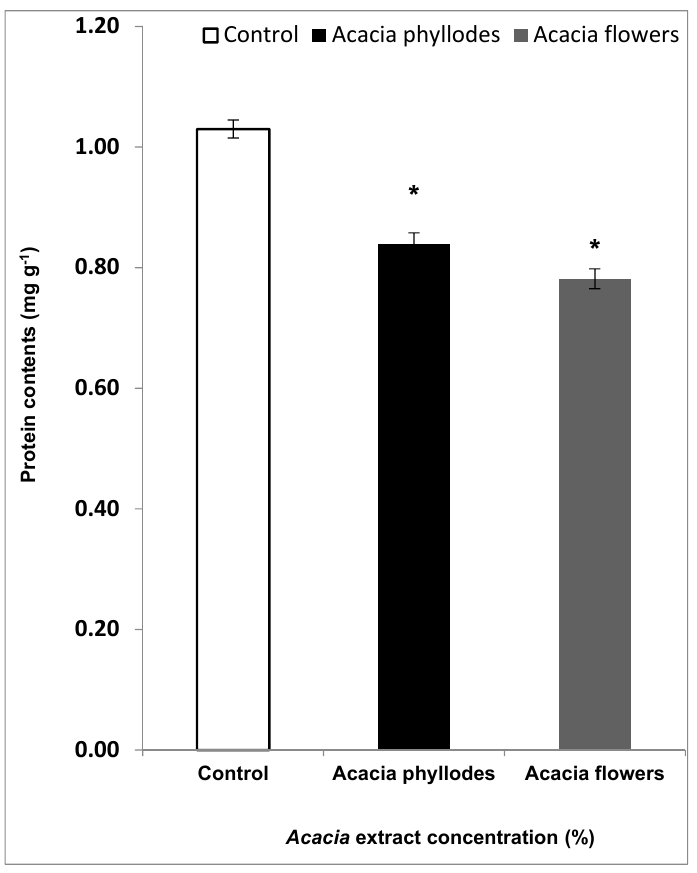
Figure 1. Inhibitory effects of A. melanoxylon flowers and phyllodes extract (0% and 100%) on the leaf protein contents (mg / g) of Lactuca sativa . Each bar represents the mean ( ± S.E.) of three replicates. *Asterisks indicate significant differences at level 0.05 with respect to the control. Table 5. Phenolics and flavonoids found in flower and phyllode extracts of Acacia melanoxylon R. Br. RT: retention time (minutes) of compounds in